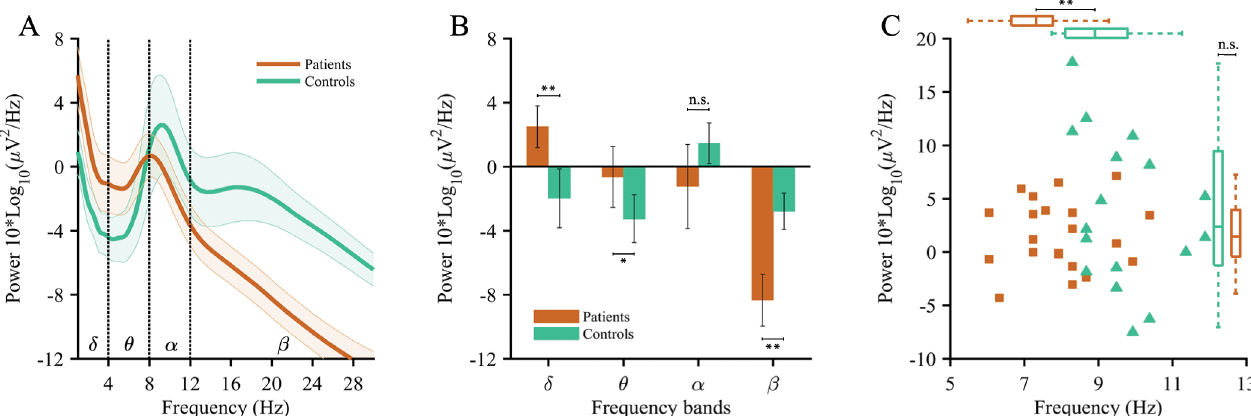
Fig 1. EEG power spectra. Wavelet convolution power spectra of the resting-state EEG data averaged over time and electrodes. (A) Mean spectra for patients (red) and controls (green), with the shaded area representing the 95%-confidence intervals. (B) Mean spectral energy (MSE) values ( ± s.e.m.) per frequency band, with significant differences in the δ (1 – 4 Hz), θ (4 – 8 Hz), and β (12 – 30 Hz) band. (C) Locations of the individual dominant α -peaks, showing a significant slowing into a lower frequency for patients (7.9 ± 0.3 Hz) as compared to controls (9.7 ± 0.3 Hz). Statistically significant differences marked as ** p < .01, * p < .05, Wilcoxon rank-sum test.